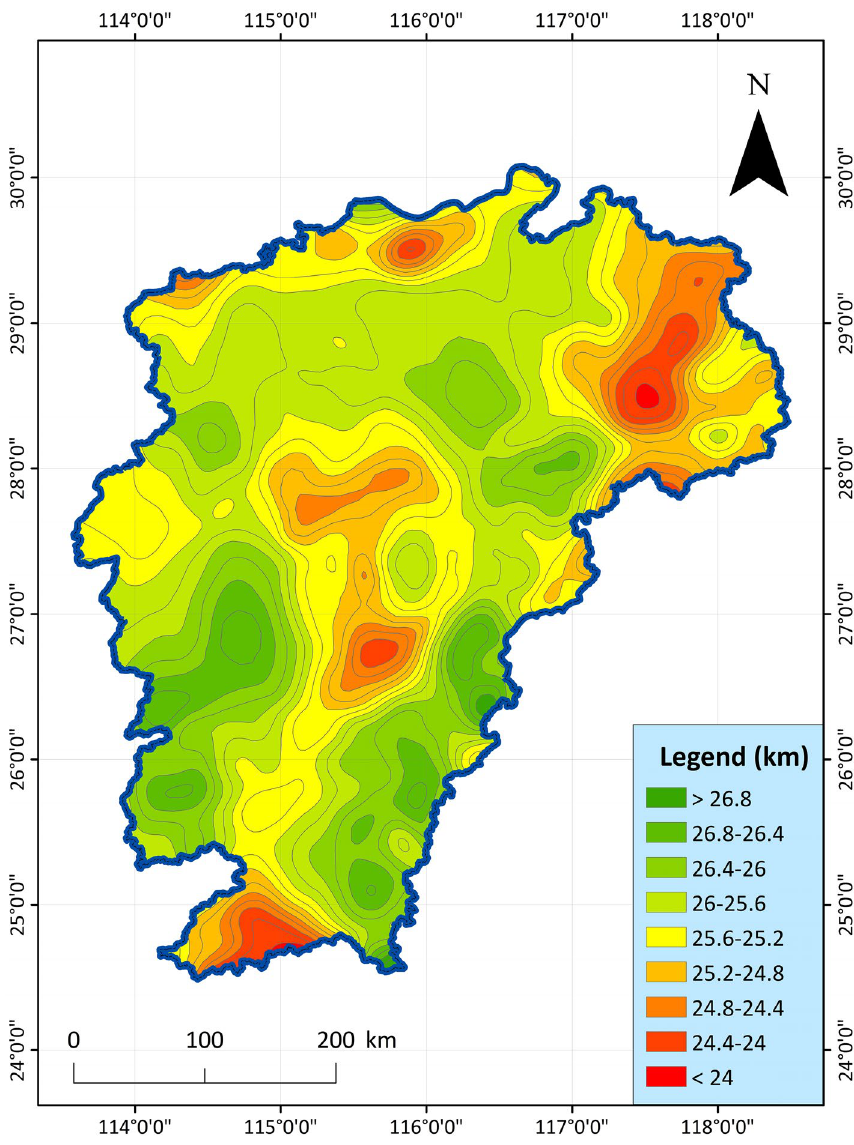
Figure 5. Distribution characteristic map of Curie depth in Jiangxi Province 51